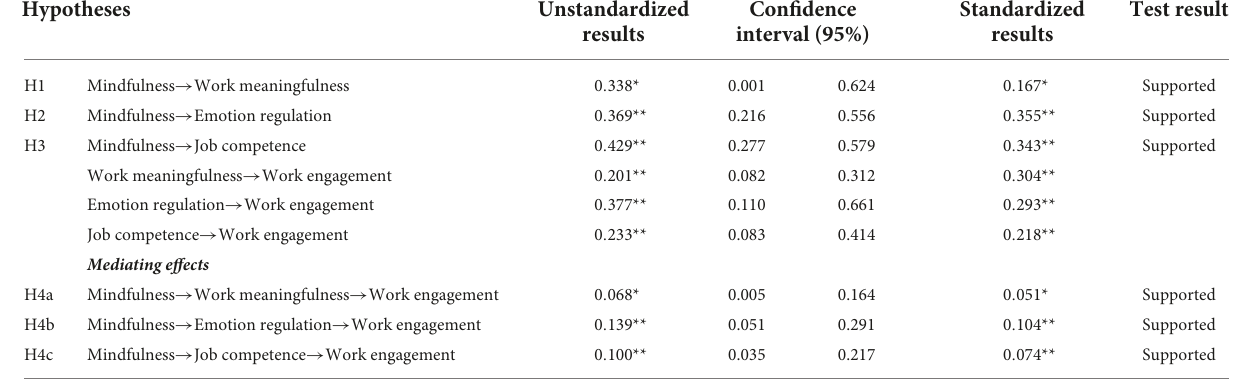
TABLE 2 Path analysis results.